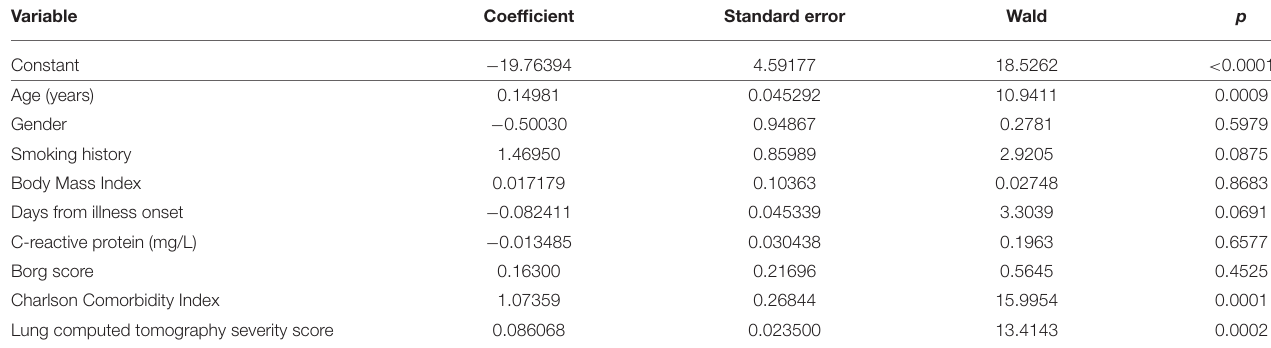
TABLE 2 | Logistic regression analysis of the dependent variables predicting the development of a severe/critical disease. Variable